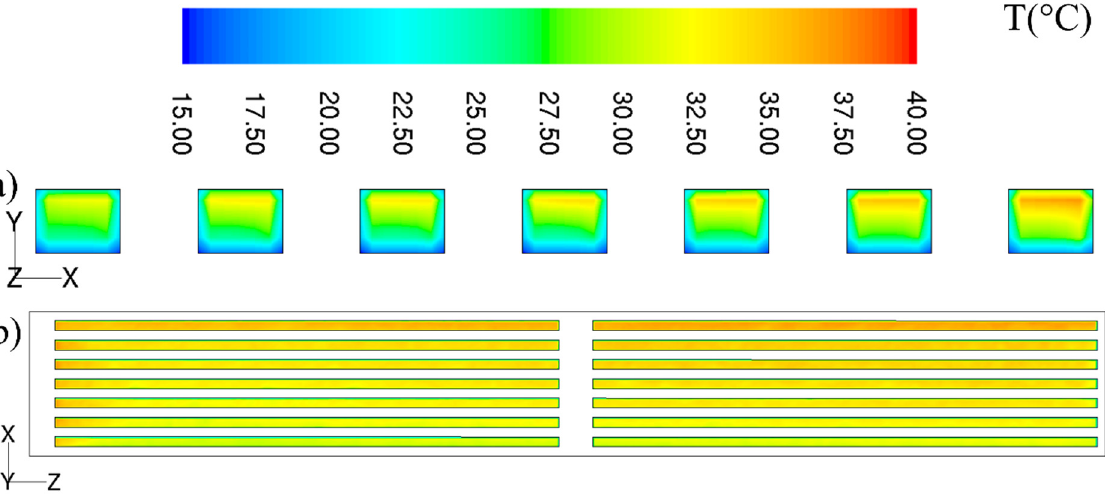
Figure 8. Crop temperature field: ( a ) vertical view at a distance z = 19 m from the door. ( b ) horizontal view at height y = 0.8 m above ground (in the top layer of the crop).